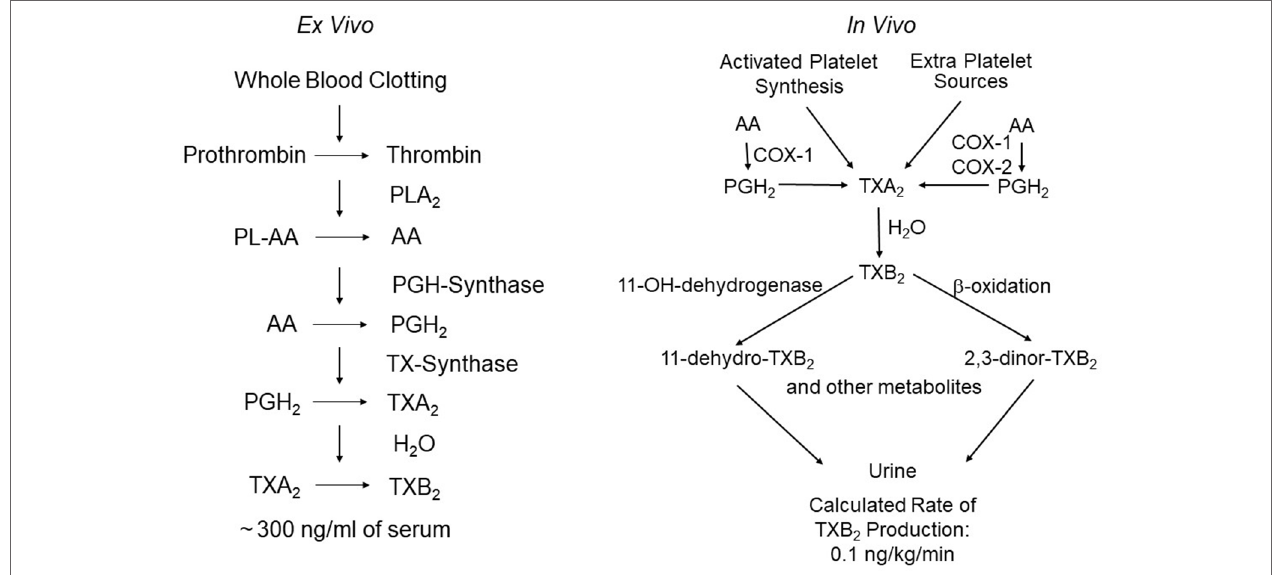
FIGURE 1 | Assessment of platelet thromboxane (TX)A 2 biosynthesis ex vivo and in vivo . The left panel depicts the chain of enzymatic reactions triggered by thrombin generation during whole-blood clotting, and the resulting formation of very large amounts of TXB 2 (the stable hydration product of TXA 2 ) that can be easily measured in serum as a sensitive and specific index of platelet COX-1 activity. The right panel depicts the metabolic fate of TXA 2 in vivo and the calculated rate of its production in healthy subjects on the basis of TXB 2 infusions and measurement of its major urinary metabolites, 11-dehydro-TXB 2 and 2,3-dinor-TXB 2 . The latter represent a non-invasive index of platelet activation in vivo . Modified and redrawn from Patrono et al.